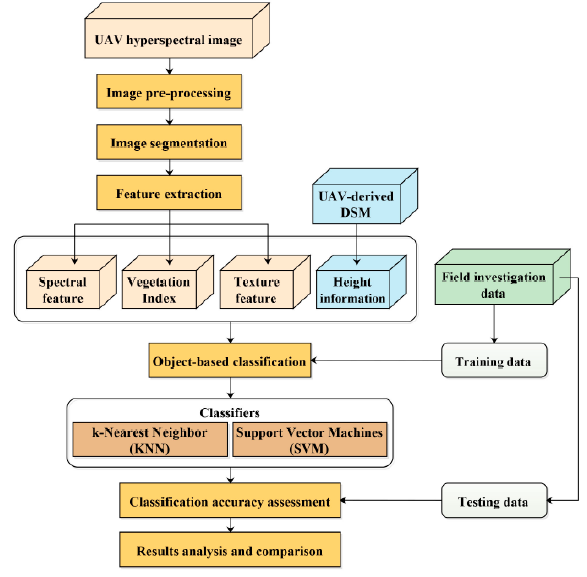
Figure 1. Methodology by Cao, et al. (2018) for object-based mangrove species classification from UAV hyperspectral image The UAV hyperspectral image and the UAV-derived DSM